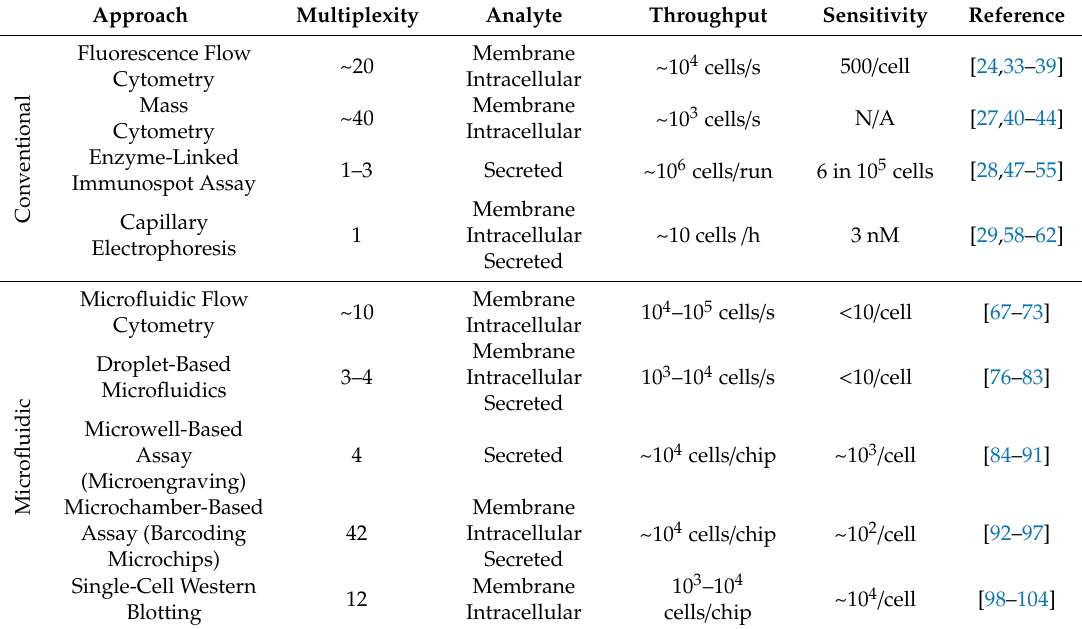
Table 1. Approach comparison of single-cell protein analysis for multiplexity, analyte, throughput, and